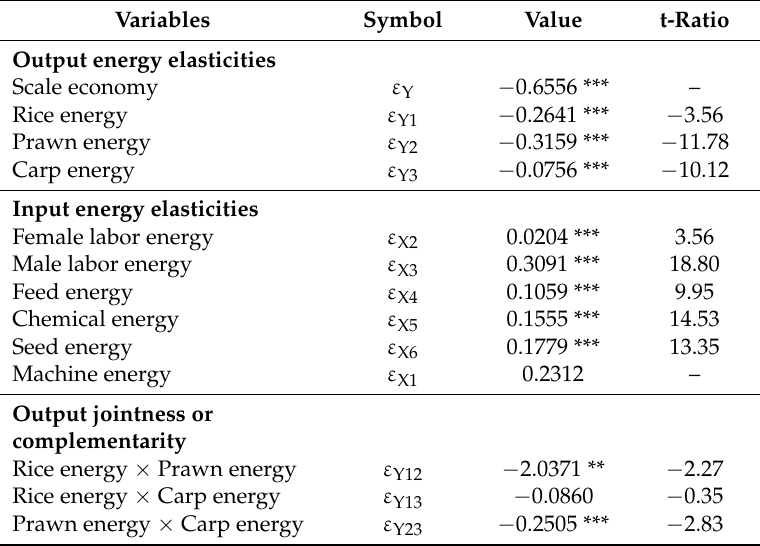
Table 6. Output jointness, input and output